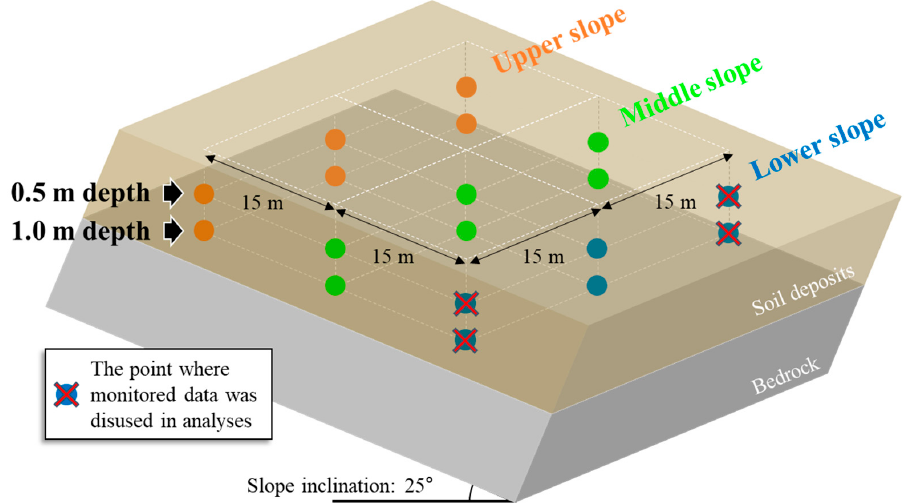
Figure 4. Diagram of VWC sensor points layout in the Songnisan landslide monitoring station.